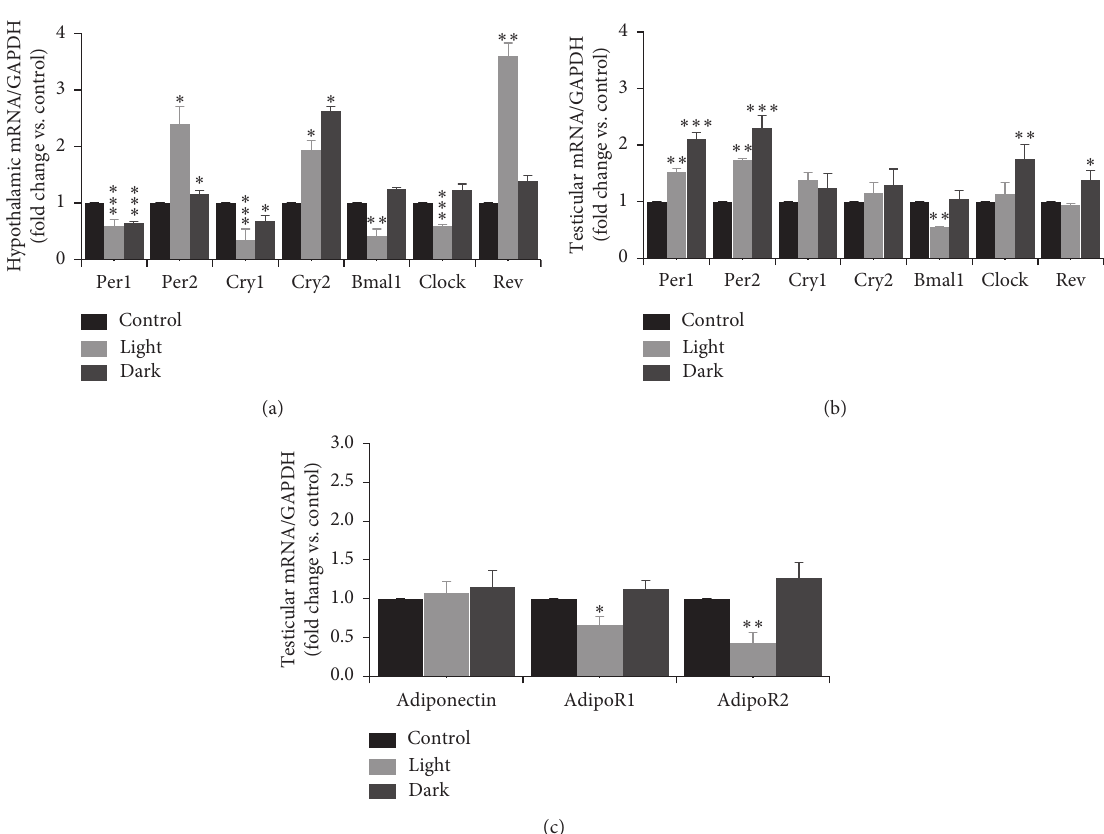
Figure 4: Q-RT-PCR analysis of hypothalamic and testicular genes expression in male rats. Clock genes mRNA expression in (a) the hypothalamus and (b) testes of male rats following exposure to prolonged light (bright gray) or prolonged dark (dark gray) for 12 consecutive weeks. (c) Testicular mRNA expression of adiponectin and adiponectin R1 and R2. Data are expressed as means ± SEM ( n � 8–10 rats). ∗ P ≤ 0 . 05, ∗∗ P ≤ 0 . 01, and ∗∗∗ P ≤ 0 .